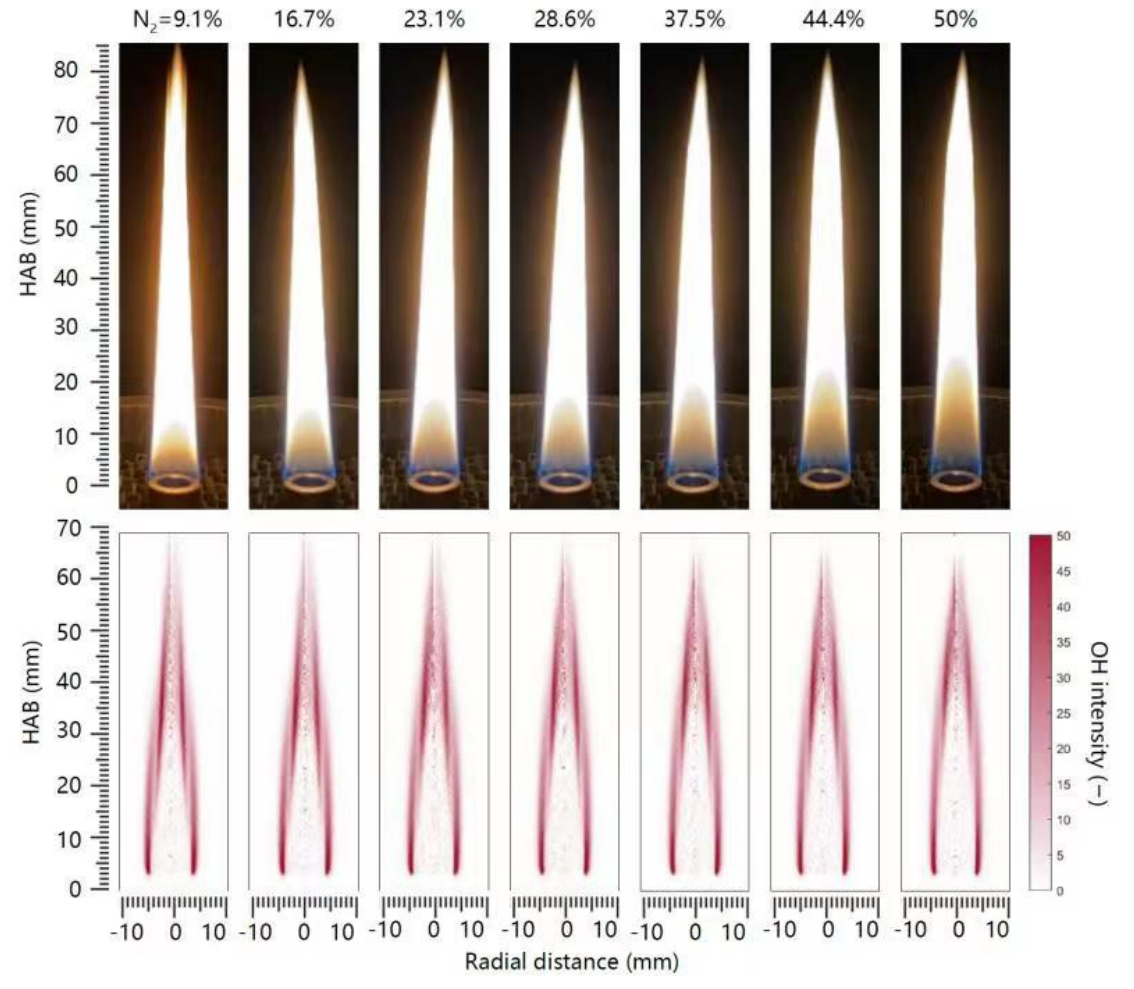
Figure 4. Flame images and the corresponding OH* chemiluminescence images of ethylene diffusion jet flame added with nitrogen at different volume percentages.